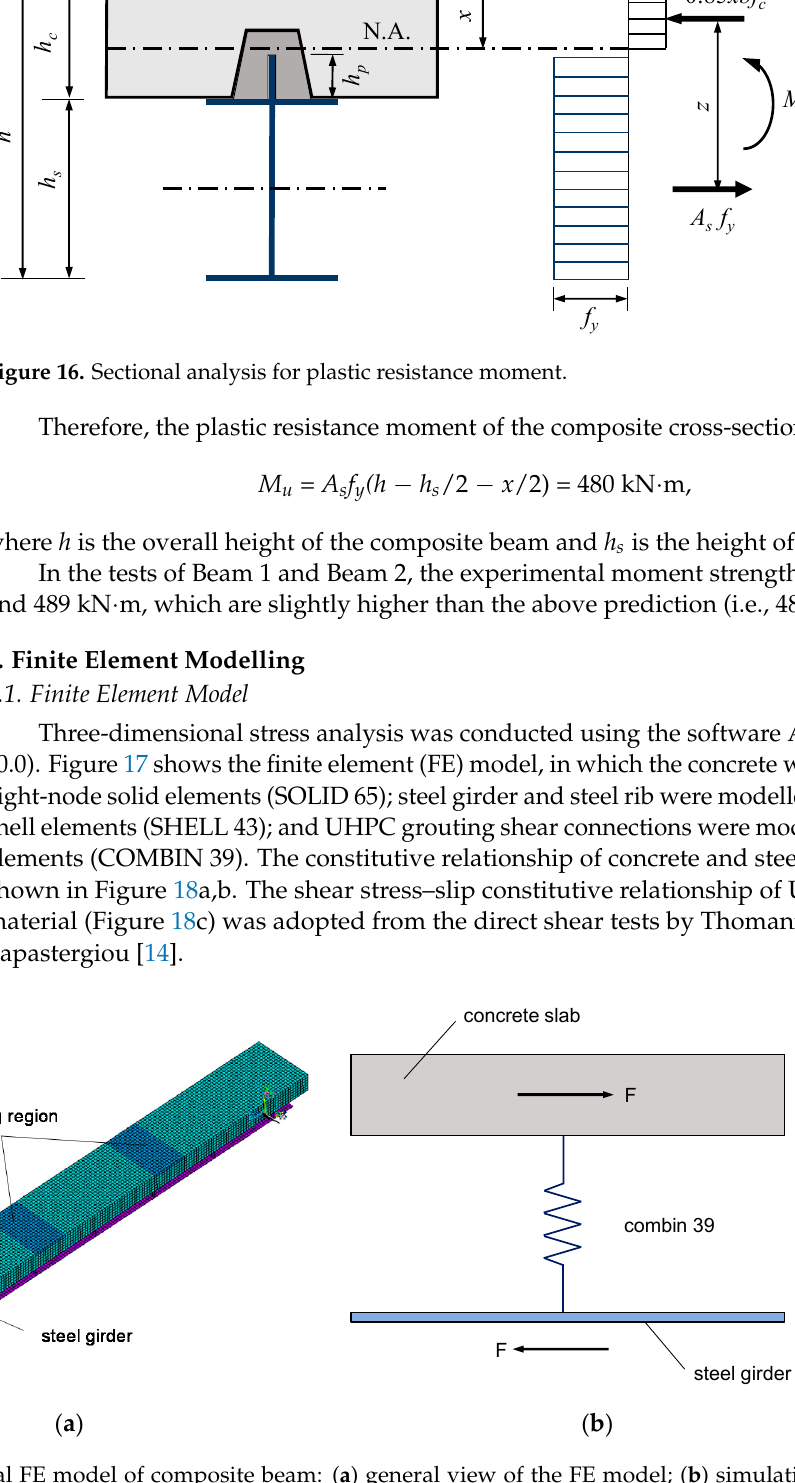
Figure 17. Three-dimensional FE model of composite beam: ( a ) general view of the FE model; ( b ) simulation of shear connections.